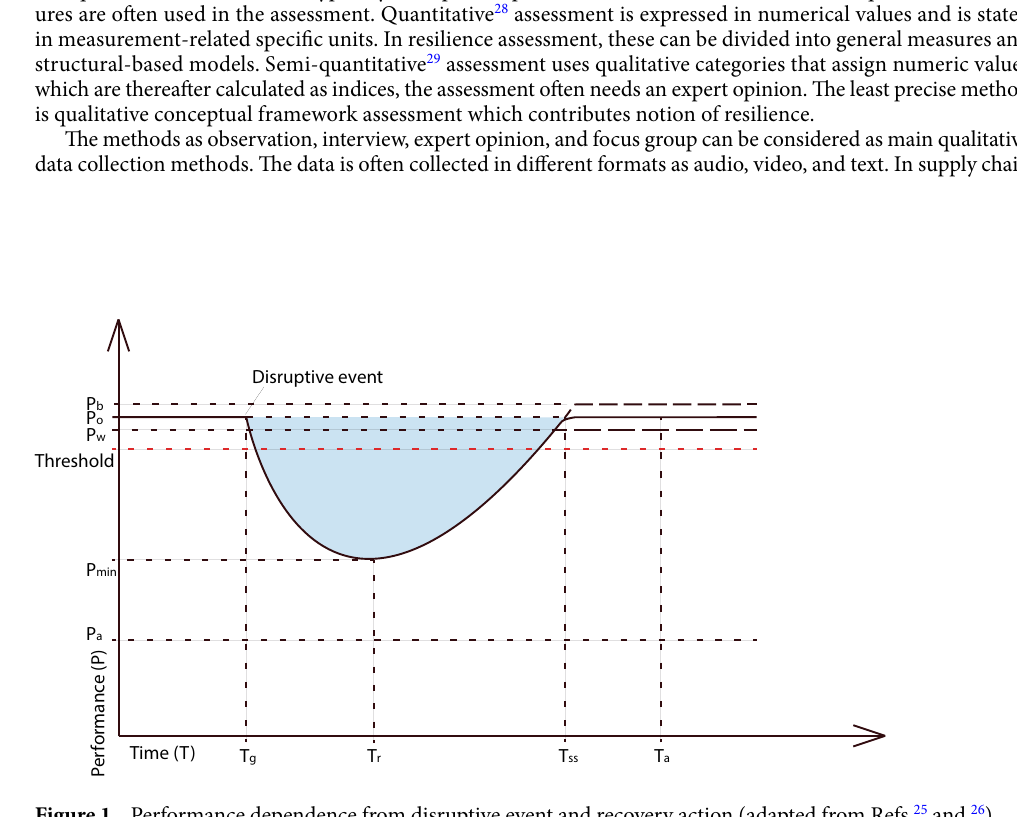
Figure 1. Performance dependence from disruptive event and recovery action (adapted from Refs. 25 and 26